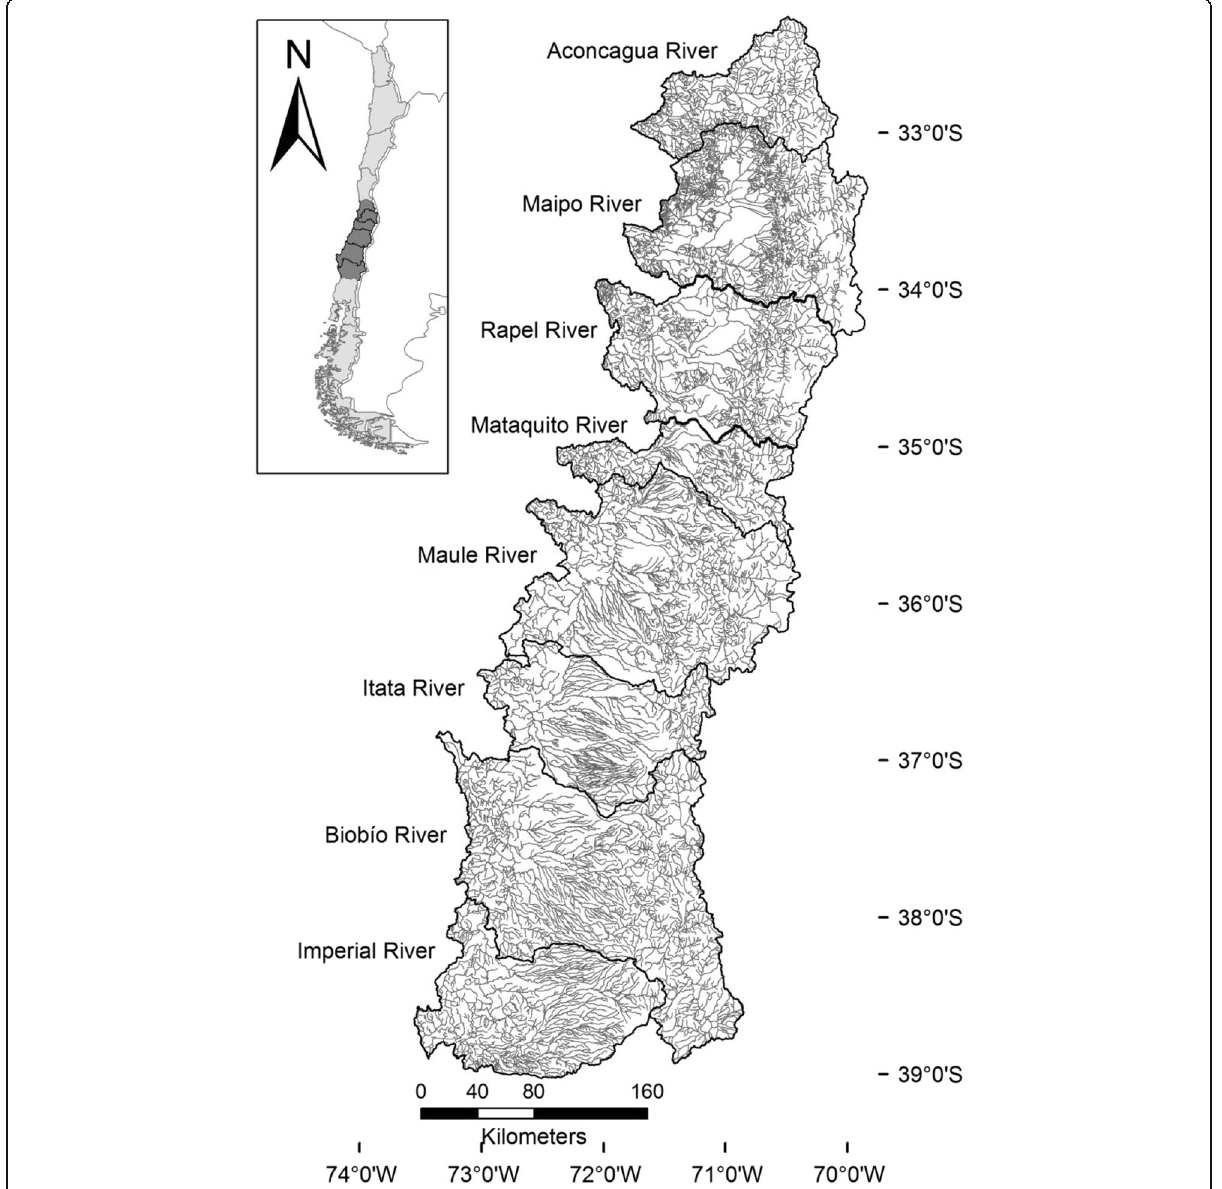
Fig. 1 Location the study area which comprises eight river network of central